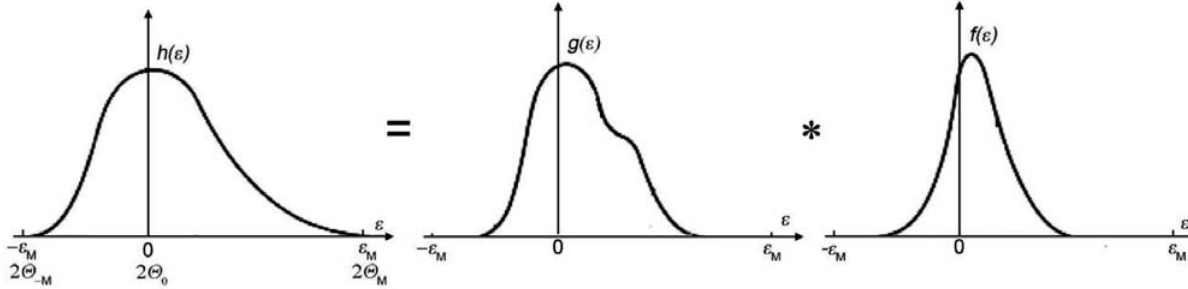
Figure 1. Observed, pure diffraction and instrumental